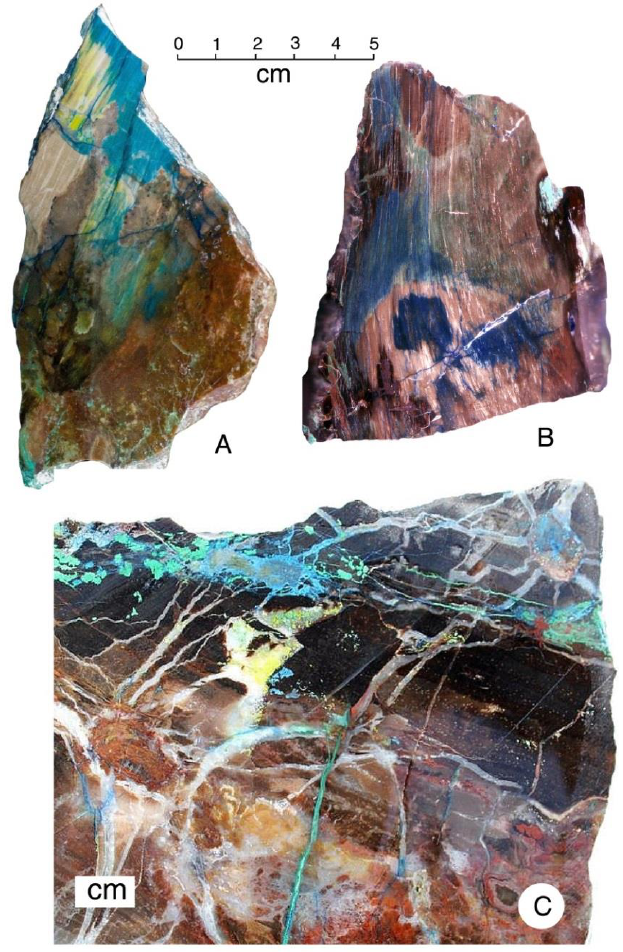
Figure 21. Color patterns are evidence of a complex mineralization sequence, where mineral-bearing solutions penetrated partially silicified wood to form diffuse color zones ( A , B ), and along fractures to produce geometric shapes ( C ).